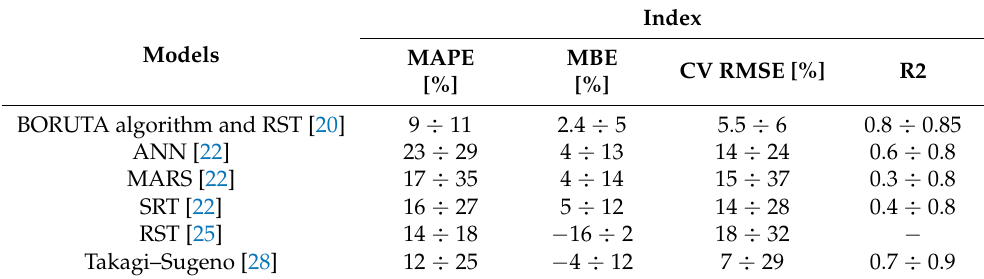
Table 1. Comparison of model quality assessment